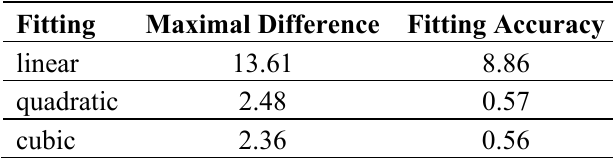
Table 1. Fitting results statistics